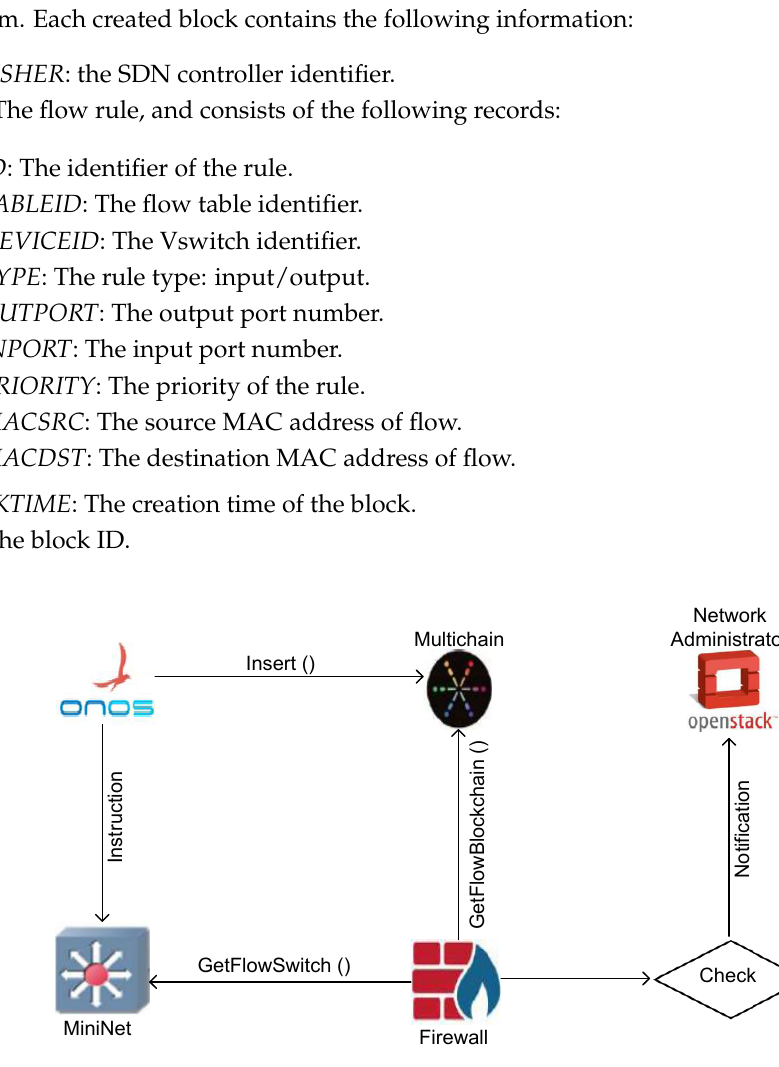
Figure 7. Implementation components of